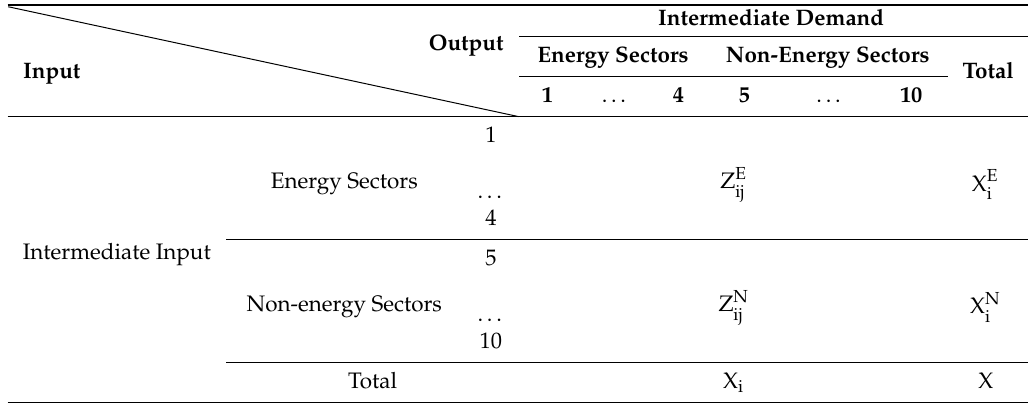
Table 1. Intermediate flows of hybrid input-output